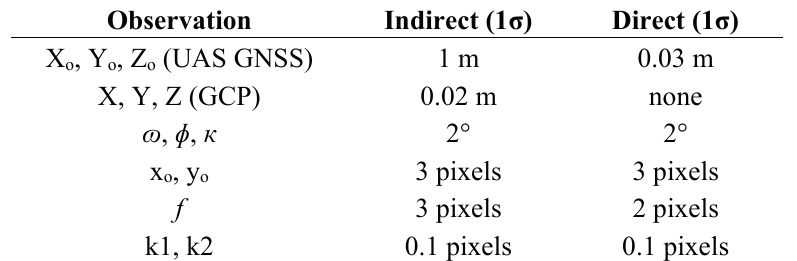
Table 2. The observations and their associated weights used in the bundle